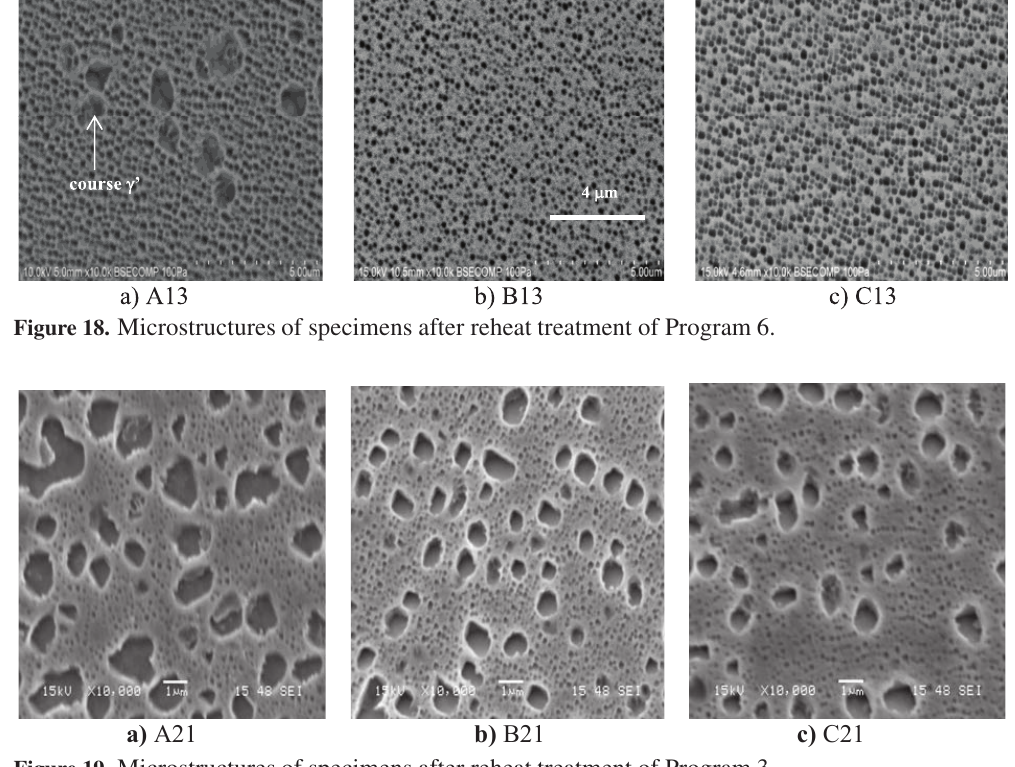
Figure 19. Microstructures of specimens after reheat treatment of Program 3.